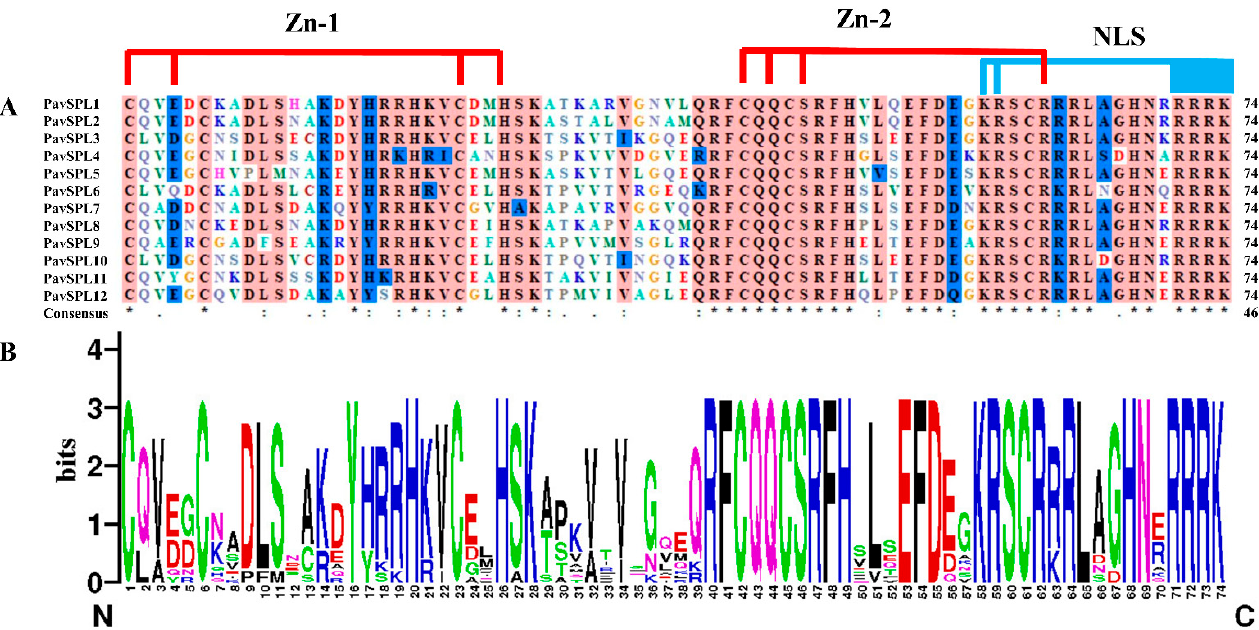
Figure 2. SBP domain alignment of the PavSPL proteins: ( A ) multiple alignments of the SBP domains of the PavSPL proteins; two conserved zinc finger structures (Zn-1, Zn-2) and NLS are shown; ( B ) sequence logos of the SBP domain by the online WebLogo (http://weblogo.berkeley.edu/logo. cgi) (accessed on: 19 November 2022). The overall height of each stack represents the degree of conservation at this position, while the height of the letters within each stack indicates the relative frequency of the corresponding amino